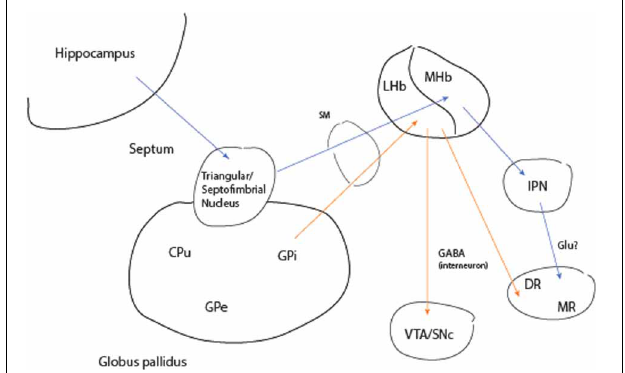
FIGURE 3 | Activation of monoaminergic nuclei by the hippocampus and globus pallidus. Blue arrows represent transmission pathway of hippocampal theta to serotonergic raphe. Orange arrows input and output of the lateral habenula. CPu, caudate putamen; DR, MR dorsal and median raphe; GABA, gamma-aminobutyric acid; Glu, glutamate; GPe, GPe, globus · pallidus external and internal segments; IPN, interpeduncular nucleus; LHb, MHb, lateral and medial habenula; SM, stria medullaris; SNc, substantia nigra pars compacta; VTA, ventral tegmental